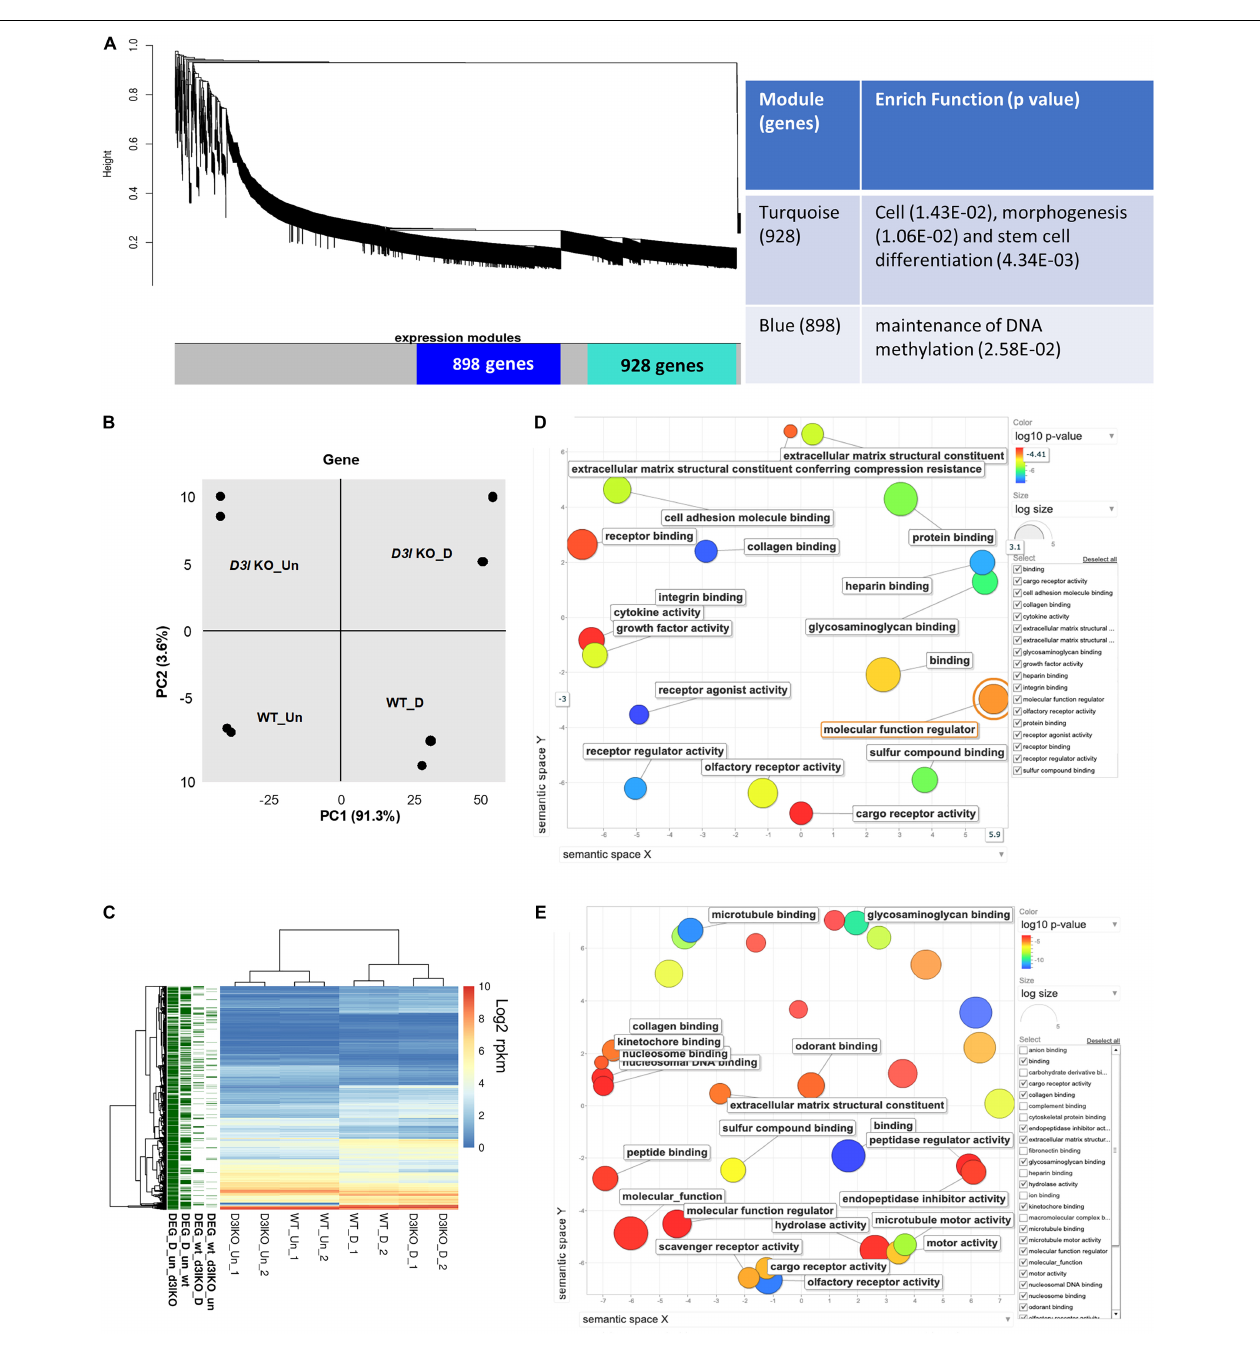
FIGURE 3 | Analyses of Dnmt3l genotype-specific differentially expressed genes (DEGs) in undifferentiated and differentiating MSCs on day 3 of osteogenic induction. (A) Weighted correlation network analysis was performed, with the two major gene modules marked in turquoise and blue. The first (turquoise block) module contains 928 genes enriched in cell, morphogenesis and stem cell differentiation. The other module has 898 genes that are categorized as maintenance of DNA methylation. (B) Principal component analysis (PCA) of gene expression. (C) Each row represents a DEG. Four groups of DEGs are shown on the left and marked in green. Most DEGs highlight the transition during differentiation. There are also differences between the WT and Dnmt3l KO MSCs, indicating the contribution of DNMT3L to these differences. The heatmaps illustrate the expression patterns of genes that are modulated by either differentiation or the DNMT3L effect. DEG_wt_d3l_un: DEGs between WT and Dnmt3l KO in undifferentiated MSCs; DEG_wt_d3lKO_D: DEGs between WT and Dnmt3l KO in differentiating MSCs; DEG_D_un_wt: DEGs between undifferentiated and differentiating MSCs derived from WT mice; and DEG_D_un_d3lKO: DEGs between undifferentiated and differentiating MSCs in Dnmt3l KO mice-derived MSCs. (D) Gene ontology analysis of DEGs between WT and Dnmt3l KO undifferentiated MSCs. (E) Gene ontology analysis of osteogenic differentiating (day 3 of osteogenic induction) DEGs between WT and Dnmt3l KO MSCs. All GO terms presented on the bubble plots have an adjusted p -value of <